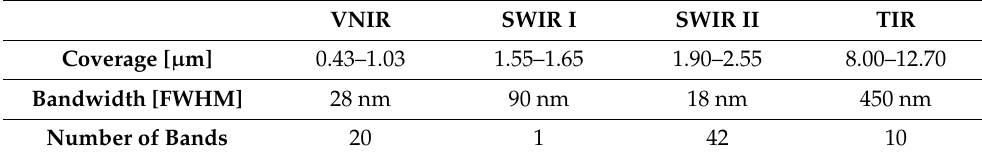
Table 2. AHS spectral configuration [49], the MIR bands (3.3–5.4 µ m) have not been